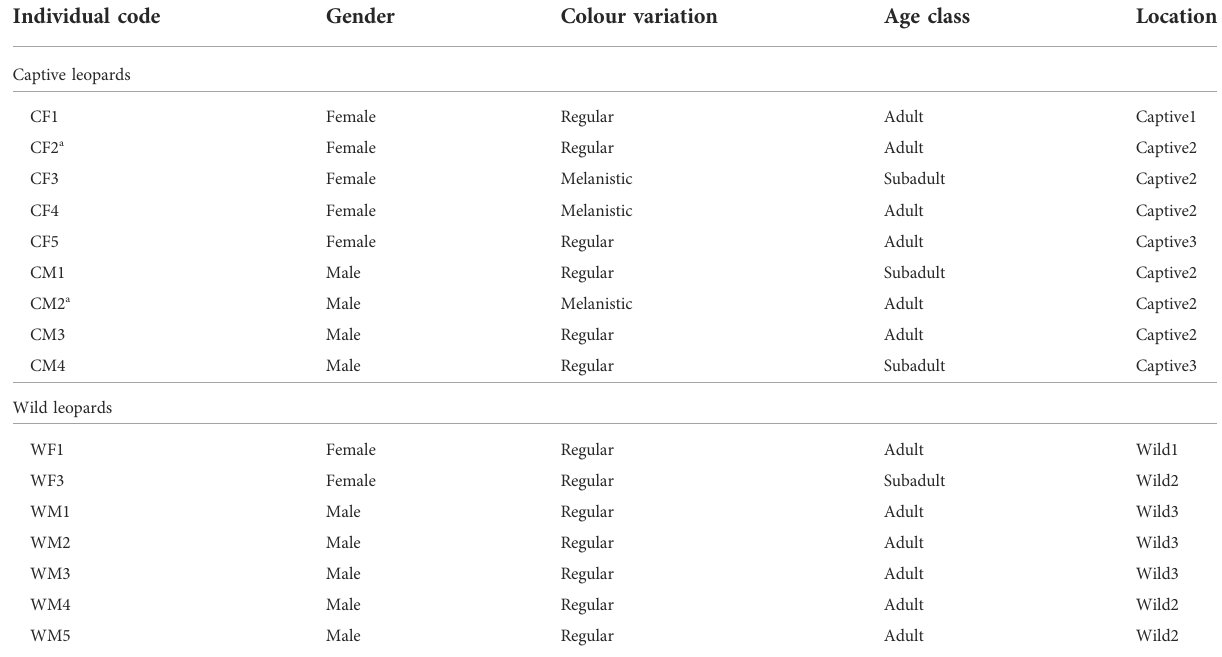
TABLE 1 Leopards sampled during this study from January 2013 to December